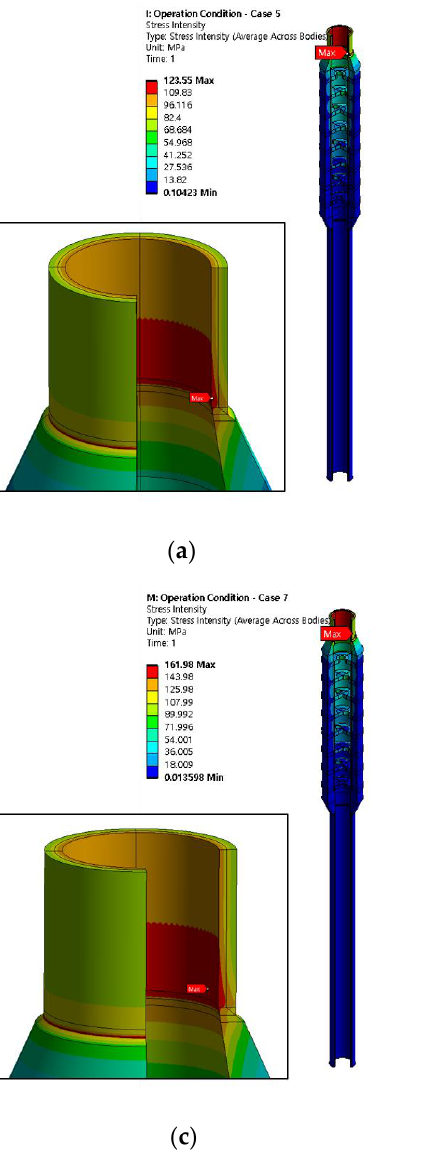
Figure 16. Distribution of the predicted stress intensity depending on the operating flow rate: ( a ) Q in = 34.1 m 3 /h (Re = 2.74 × 10 5 ); ( b ) Q in = 37.0 m 3 /h (Re = 2.97 × 10 5 ); ( c ) Q in = 39.0 m 3 /h (Re = 3.13 × 10 5 ); and ( d ) Q in = 41.5 m 3 /h (Re = 3.33 × 10 5 ).